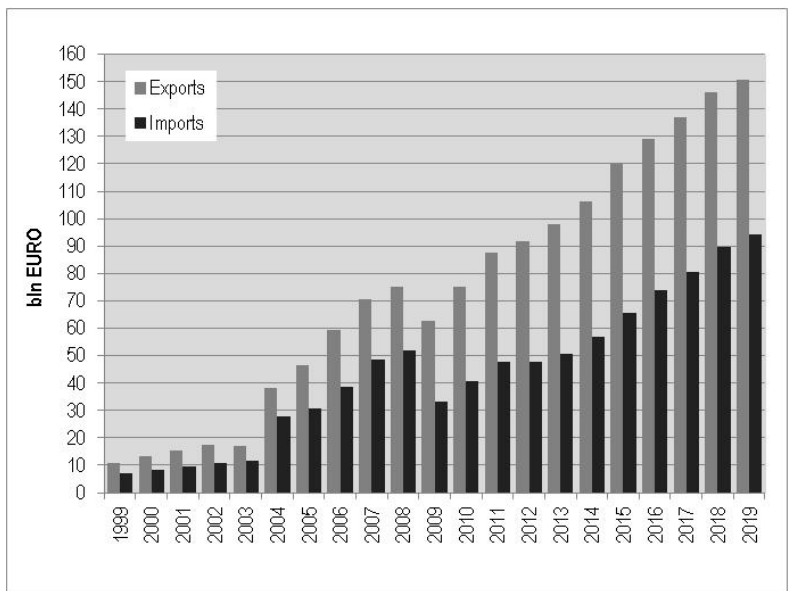
Figure 1. Dynamics of automotive exports and imports of Central European countries 1999–2019. Source: authors’ elaboration based on Eurostat data [54].